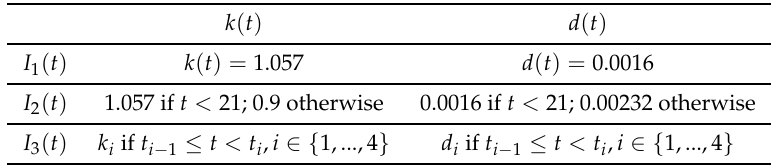
Table 3. Summary of the values used in Figure 1c to obtain the curves I 1 ( t ) , I 2 ( t ) and I 3 ( t ) . Recall that k 1 = 1.057, k 2 = 0.9, k 3 = 0.67, k 4 = 0.71, d 1 = 0.0016, d 2 = 0.00232, d 3 = 0.00232, d 4 = 0.0068, t 0 = 0, t 1 = 21, t 2 = 24, t 3 = 27 and t 4 = 32.